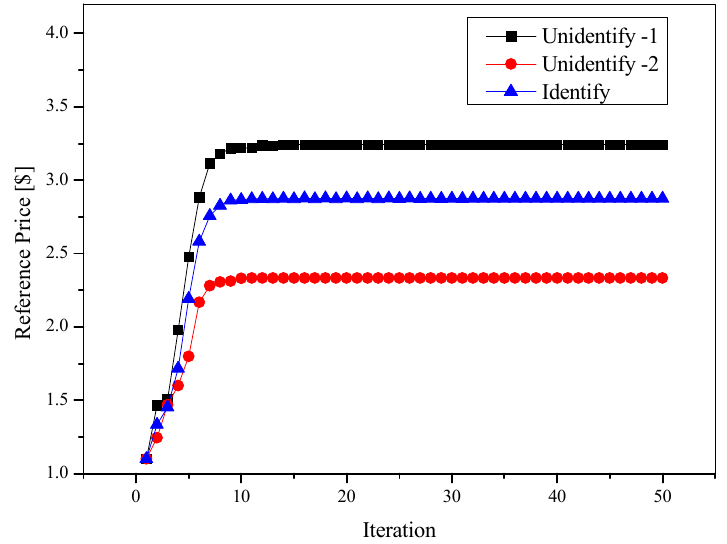
Figure 8. Comparison of price with Identify case and Unidentified cases.